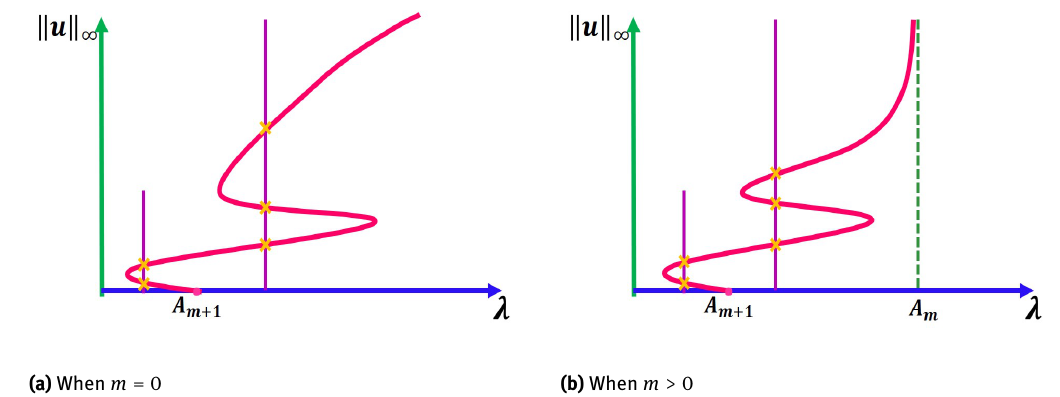
Fig. 2: An expected bifurcation diagram for (1.1) when hypotheses of Theorem 1.1 ( b ) are satisfied.